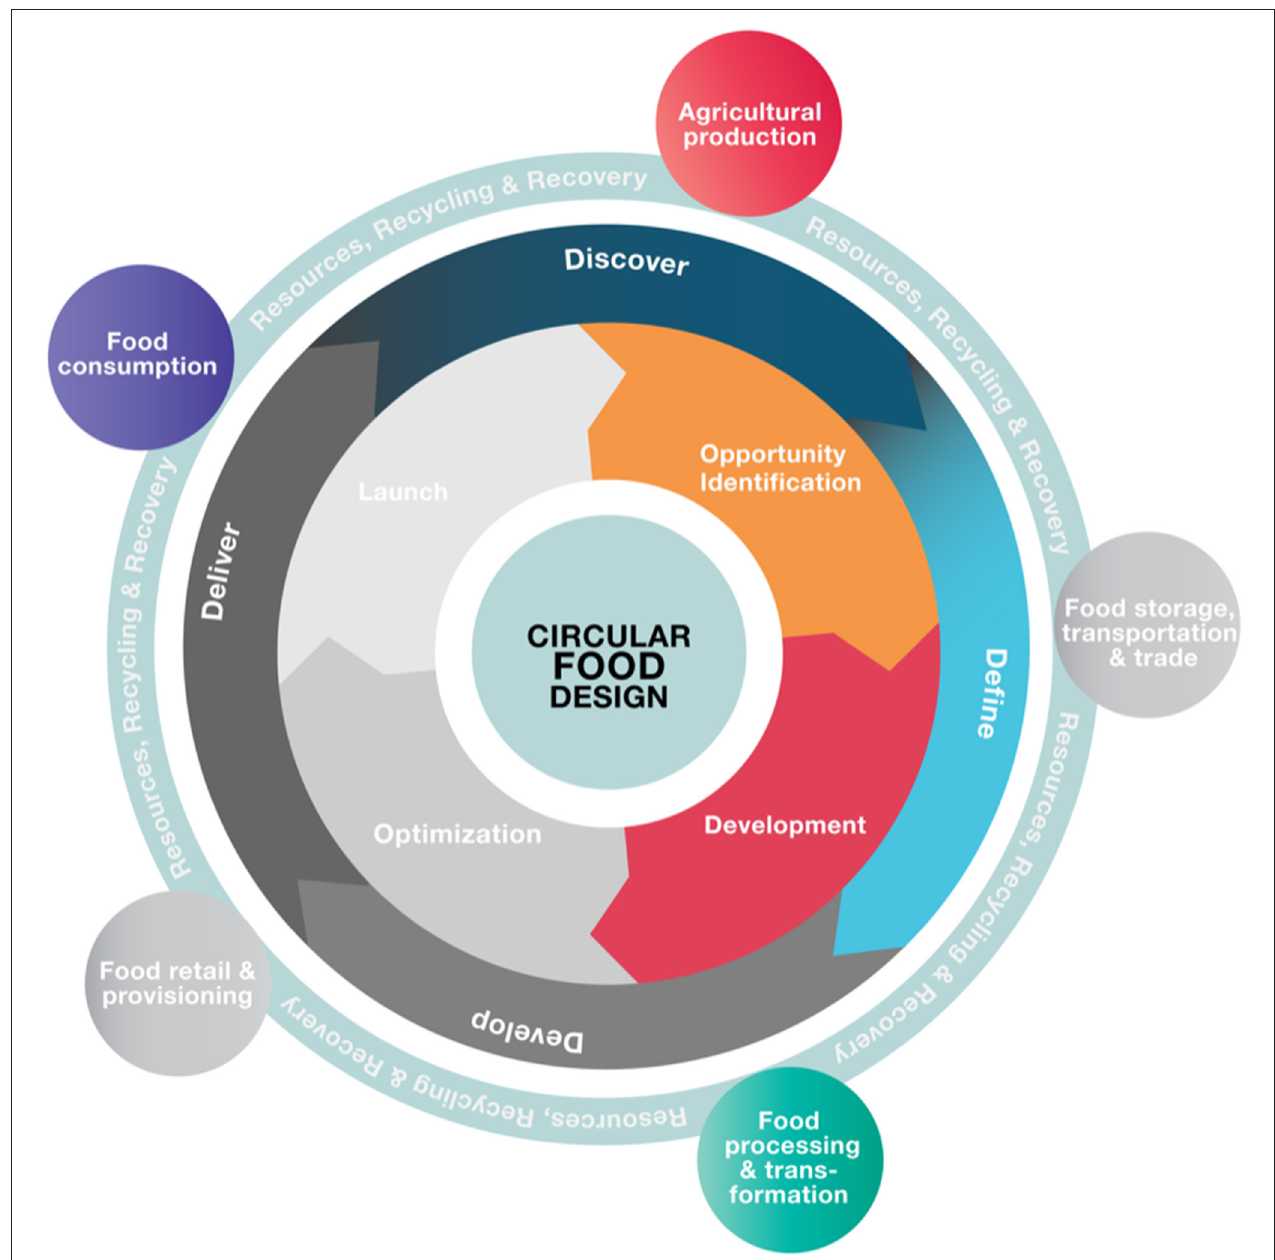
FIGURE 4 | Circular food design, application too much fruit, too little consumption.